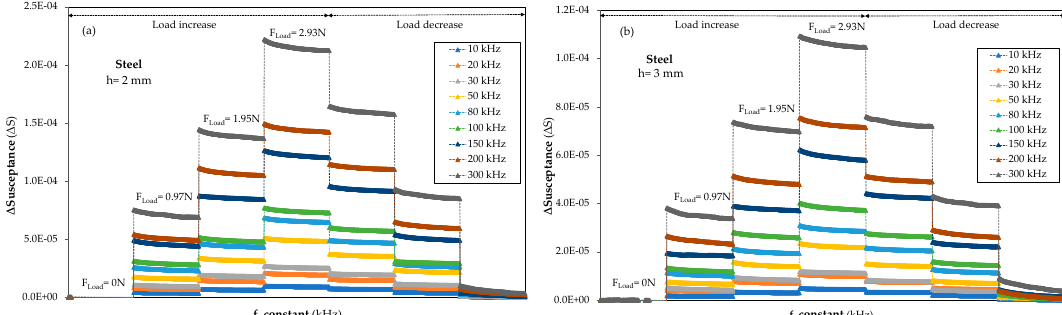
Figure 5. Figure 5. Cont.